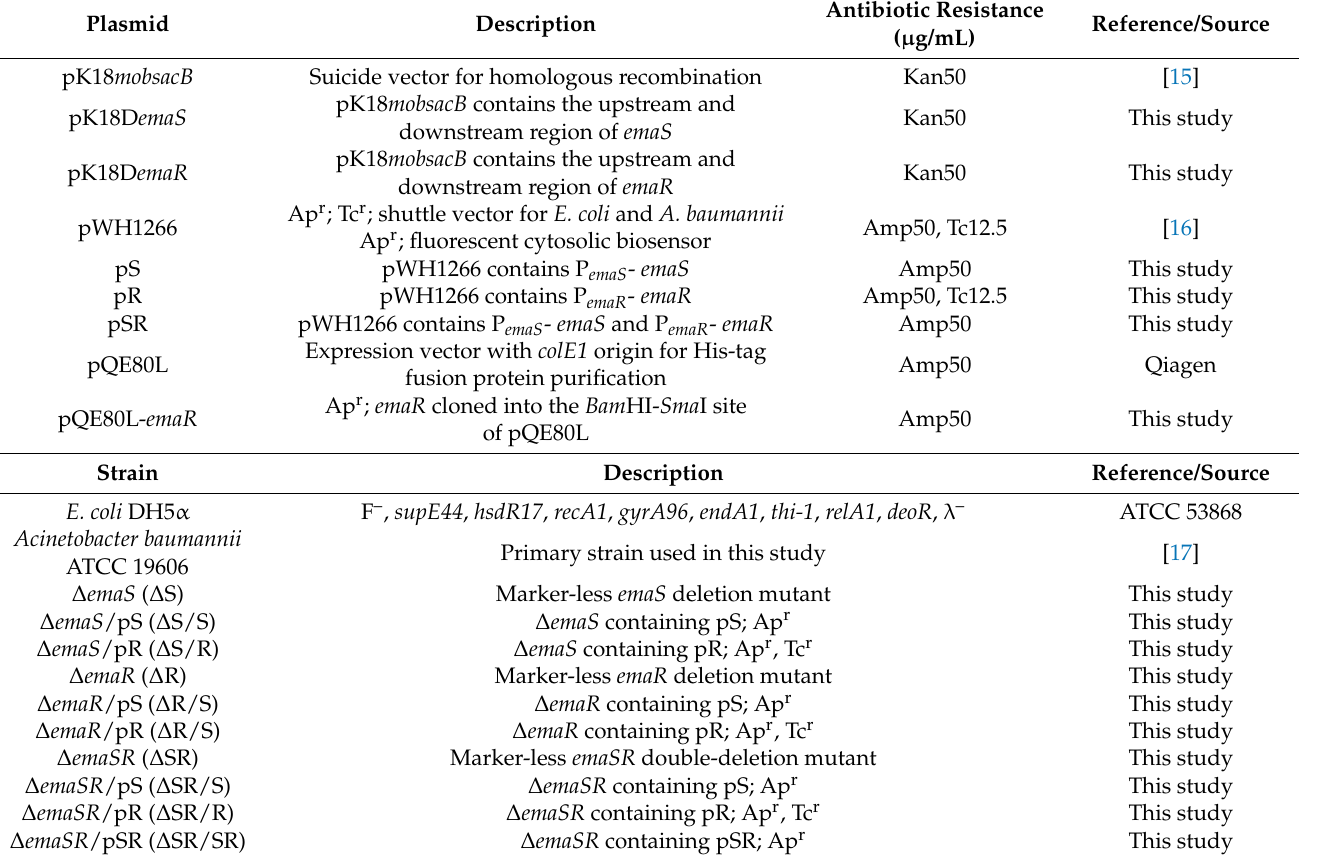
Table 1. Plasmids and bacterial strains used in this